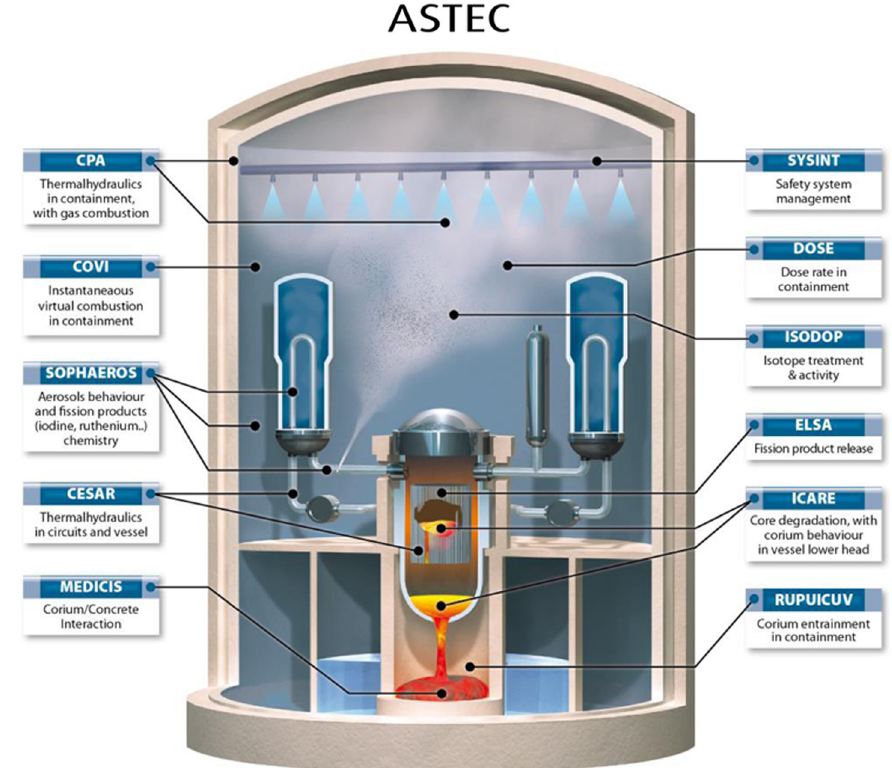
Fig. 7. ASTEC integral code for simulation of severe accidents ( © IRSN, 2016).